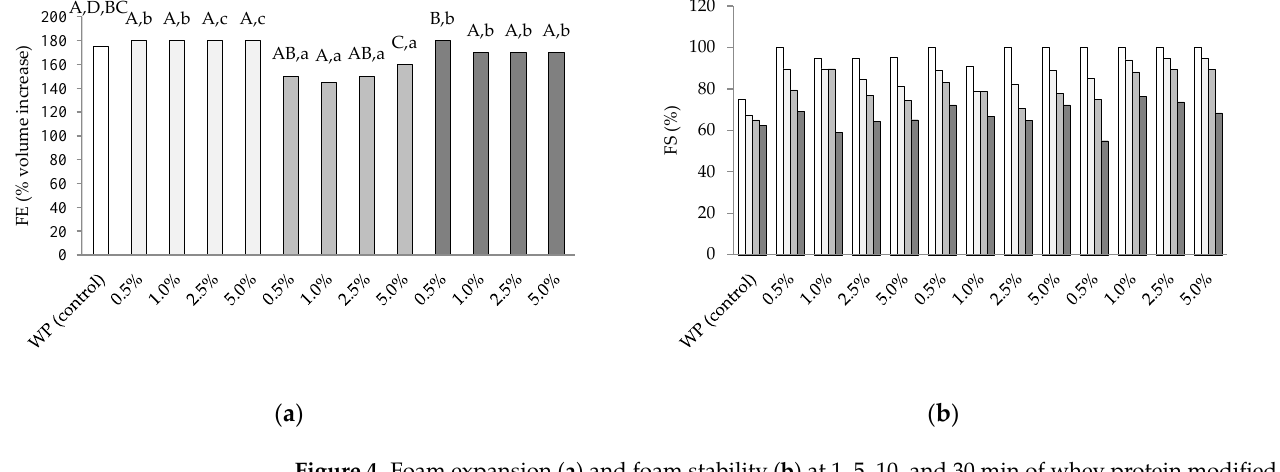
Figure 4. Foam expansion ( a ) and foam stability ( b ) at 1, 5, 10, and 30 min of whey protein modified with different oxidized phenolic compounds at various concentrations. Different letters in the same concentration of oxidized phenolic compounds indicate significant differences. Different capital letters in the same type of oxidized phenolic compounds and control indicate significant differences.